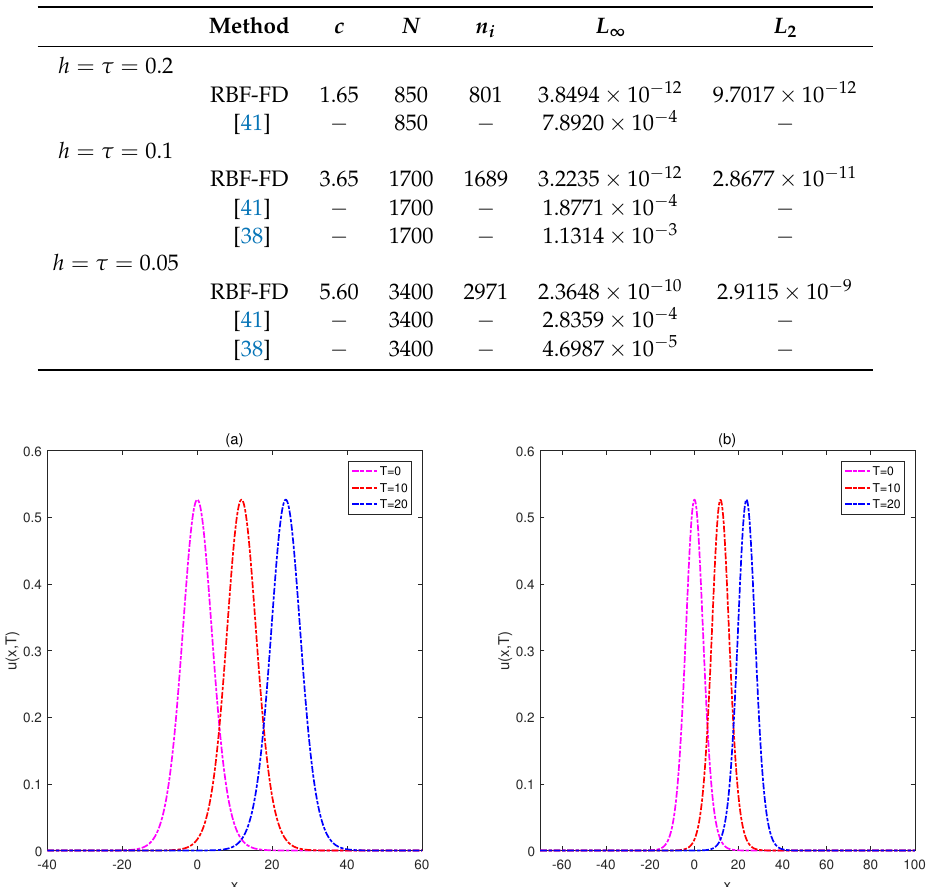
Table 2. The L ∞ and L 2 errors under different mesh steps h = τ at T = 40 for Example 1.